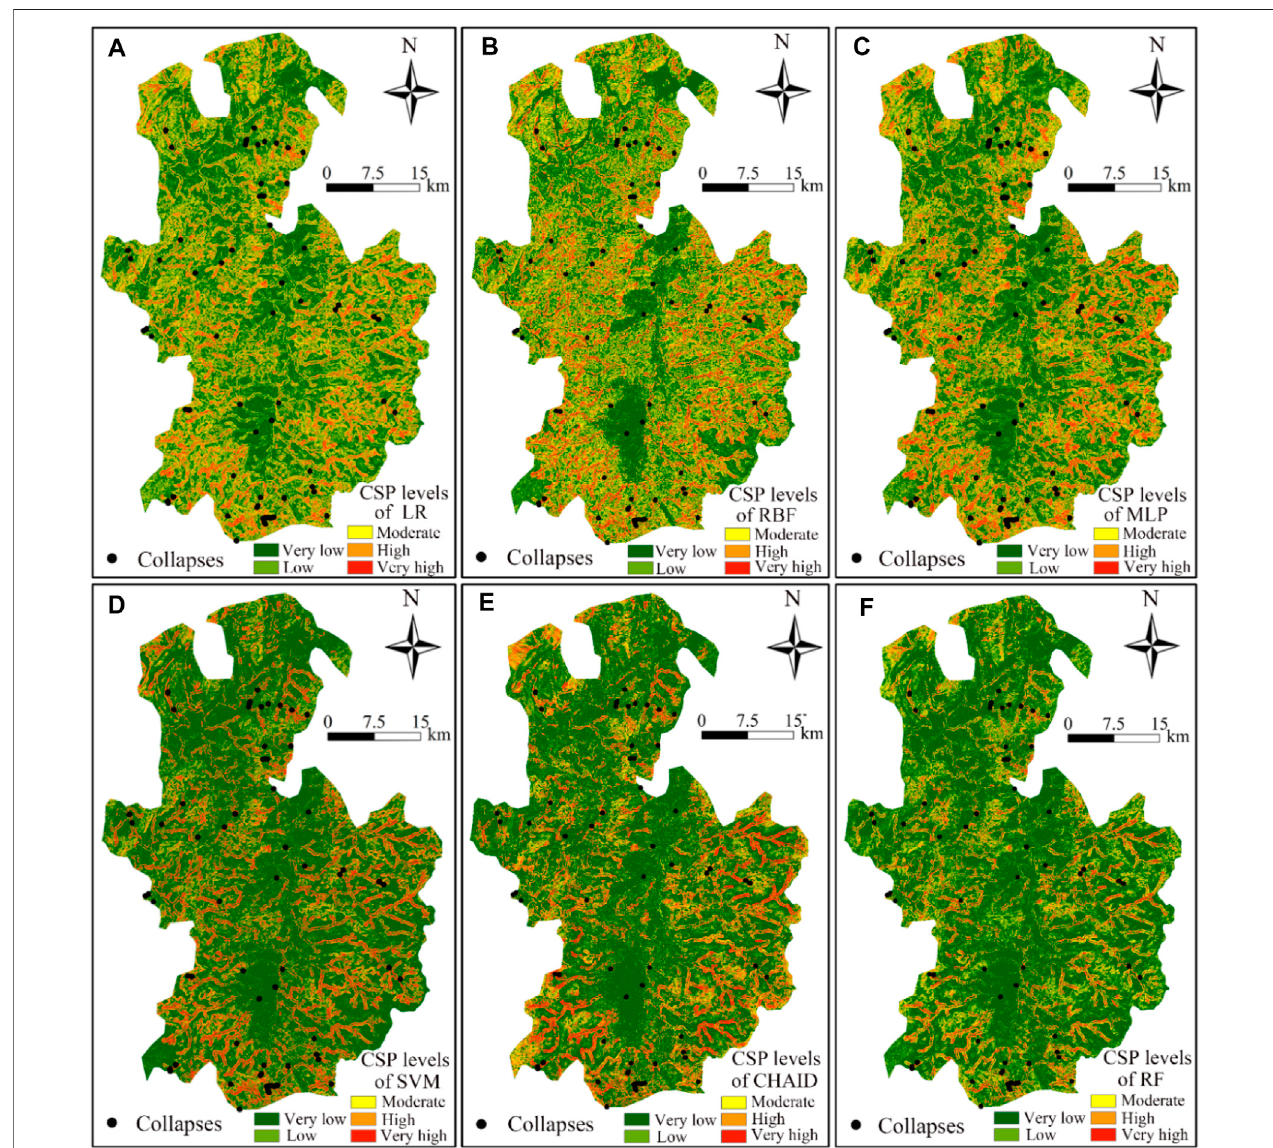
FIGURE 10 | Collapse susceptibility graph using machine learning models in Huichang county: (A) LR, (B) RBF, (C) MLP, (D) SVM, (E) CHAID, (F) RF models.